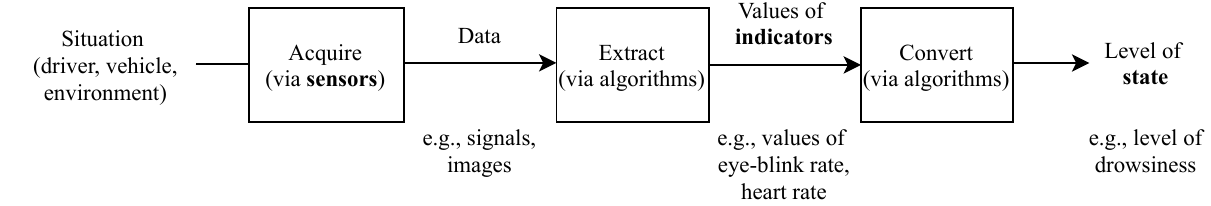
Figure 2. The figure shows, for the context of driver monitoring (DM), the system block diagram applicable to the characterization of a generic (sub)state. The input is the situation of interest and the output is the level of the state. The operation of each of the three subsystems is described in the